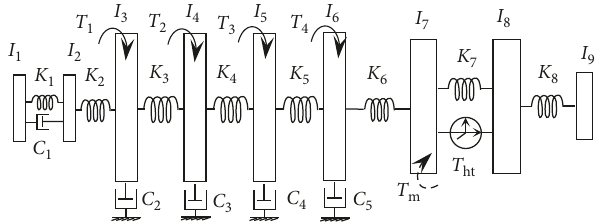
Figure 3: Analytical model of DMF driveline under start-up condition.